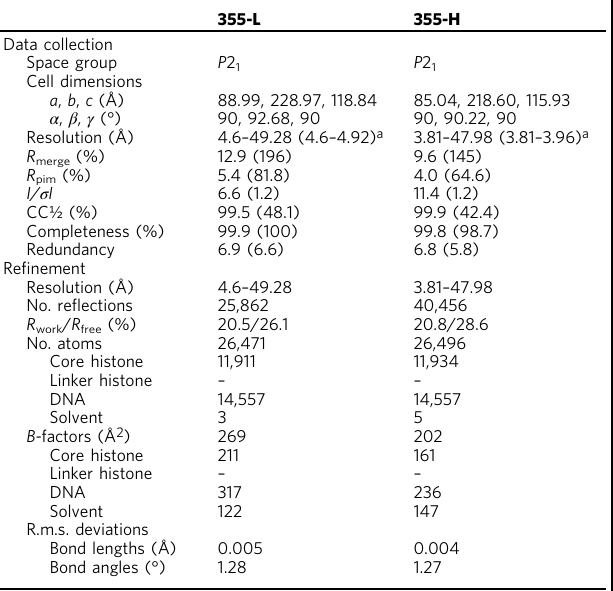
Table 2 Data collection and re fi nement statistics for 355 dinucleosome crystals stabilized in either a low (L) or high concentration (H) of cryoprotectant.